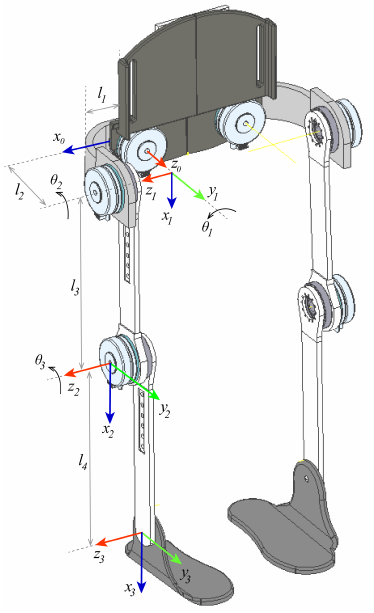
Figure 5. Reference frames using Denavit–Hartenberg (DH)